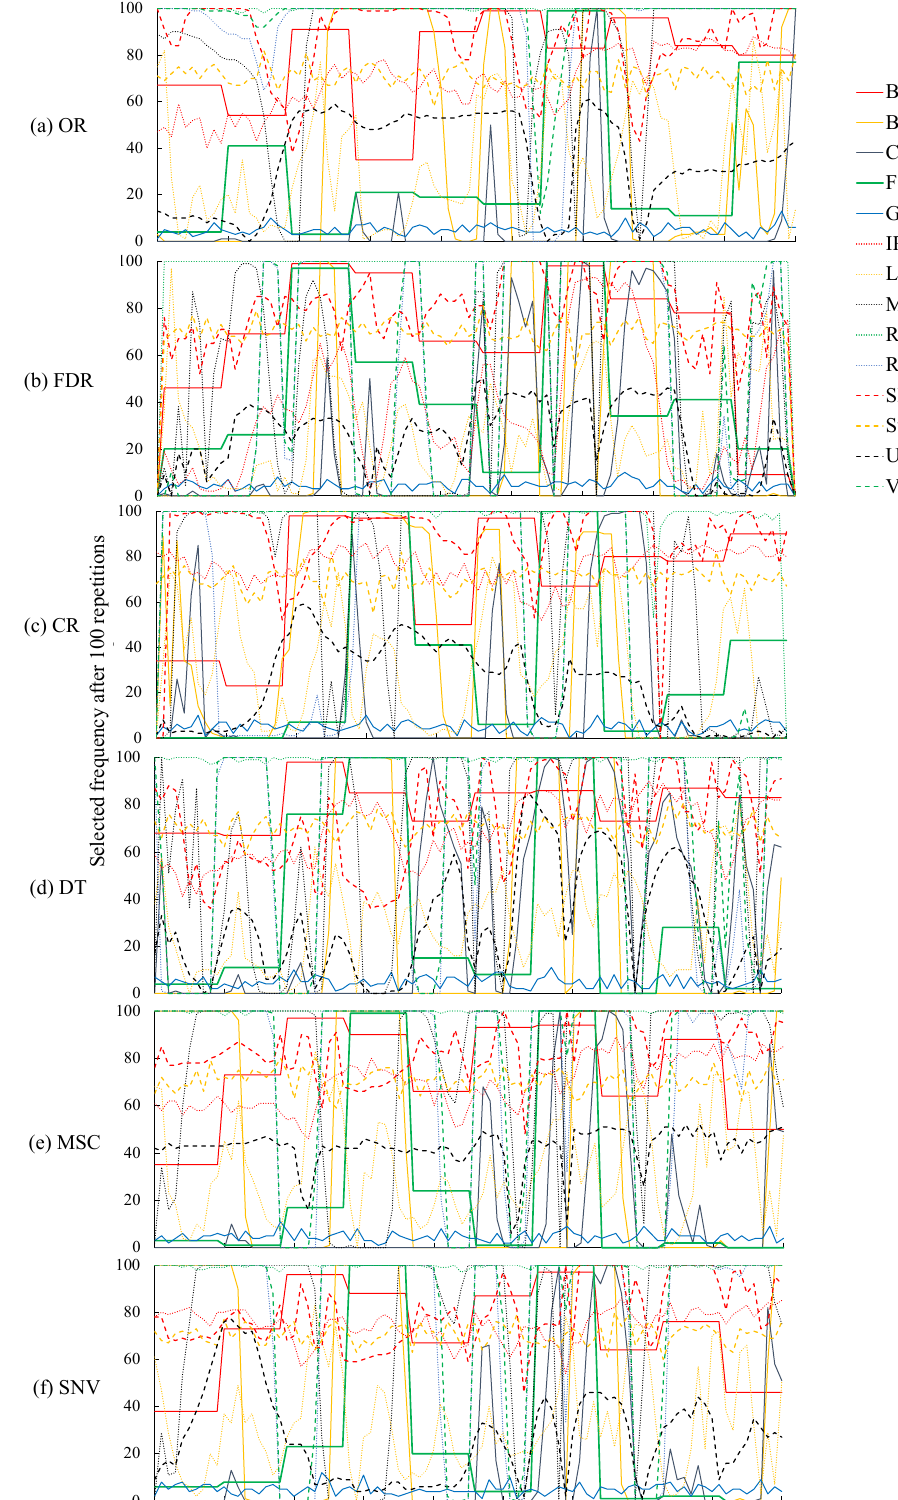
Figure 6. Frequency of selection for each wavelength based when using different variable selection methods and preprocessing techniques.